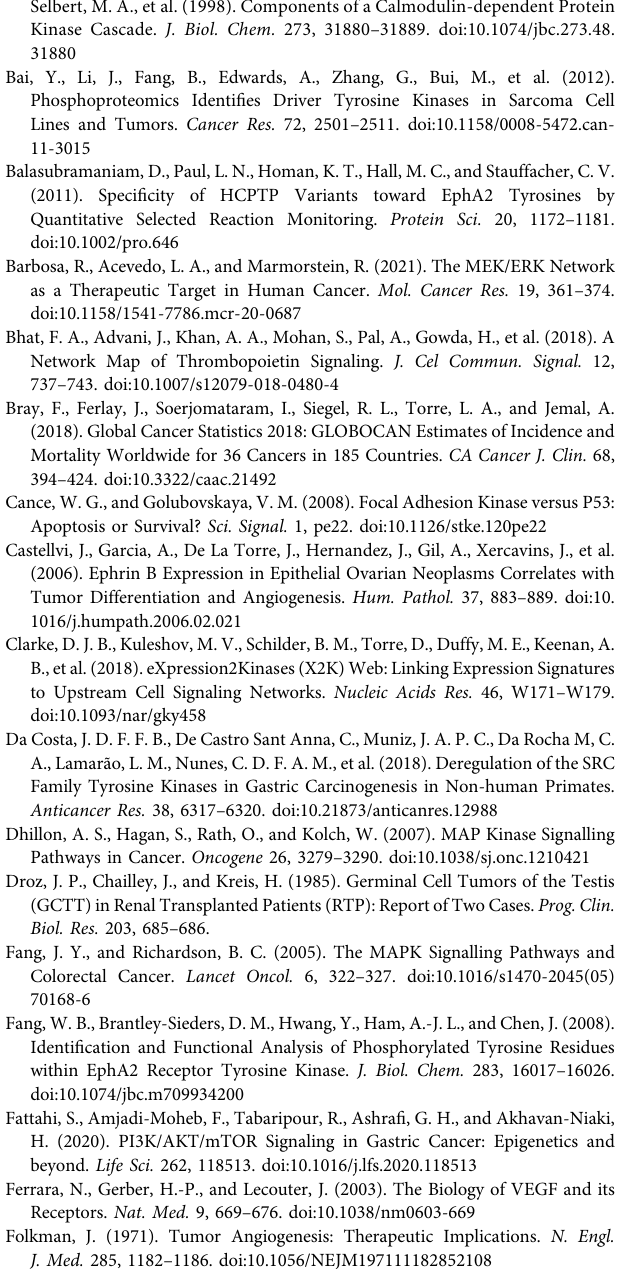
Supplementary Figure 6 | Venn diagram of proteins identi fi ed between the control and STO-609 treated in AGS cells. (A) Venn diagram showing the protein identi fi cations between triplicates in control sample. (B) Venn diagram showing the protein identi fi cations between triplicates in STO-609 treated sample. (C) Venn